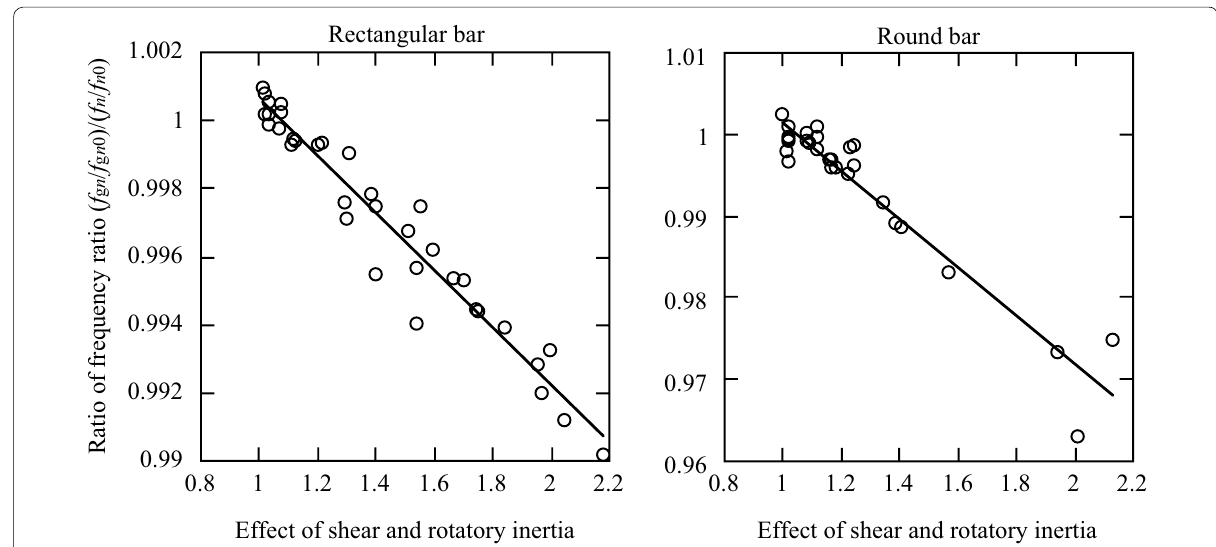
Fig. 4 Relationship between the ratio of frequency ratio ( f g n / f g n 0 )/( f n / f n 0 ) and the effect of deflections due to shear and rotatory inertia involved in the bending vibrational deflection